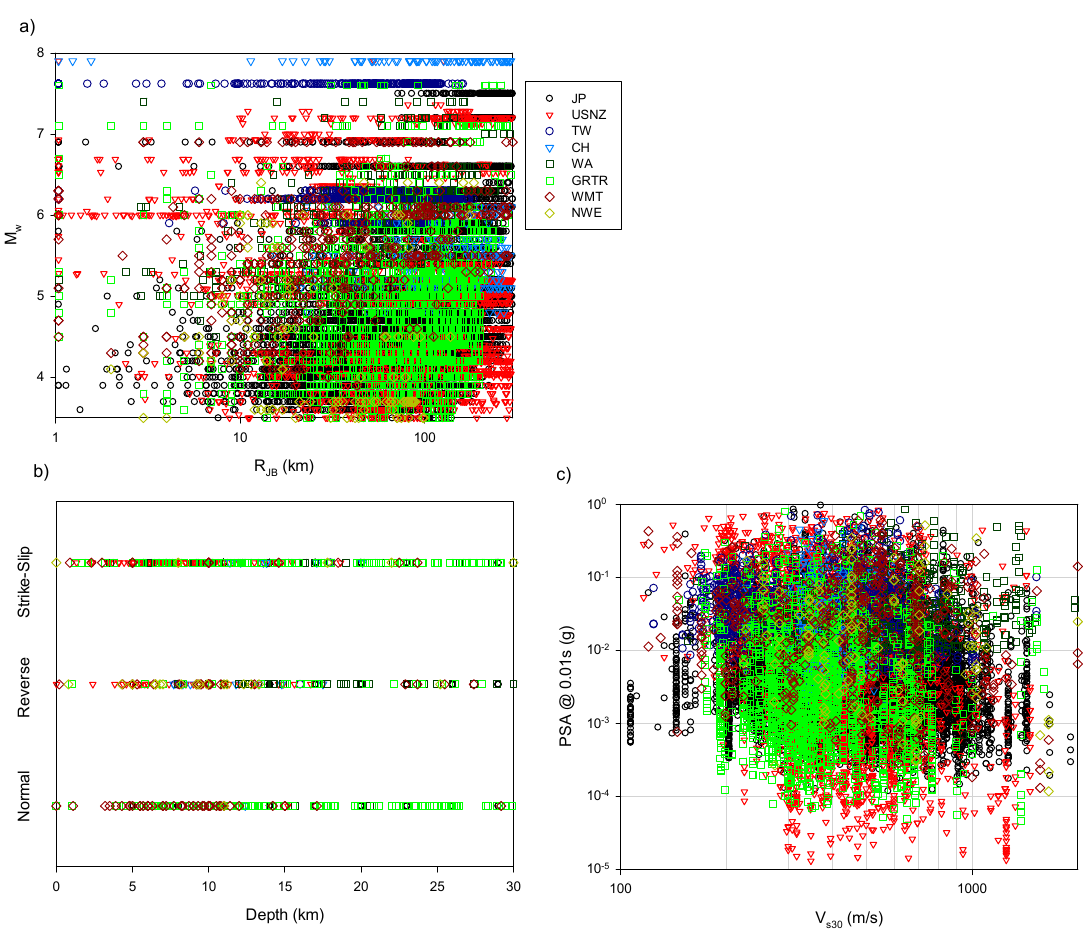
Figure 1. Seismological features of the database ( a ) R JB - M w scatters, ( b ) Depth vs. style-of-faulting, and ( c ) V S 30 vs. PSA at T = 0.01 s. Note that the larger seismic regions are shown with the same color-code in each plot. Table 1. Standard deviation model of the site